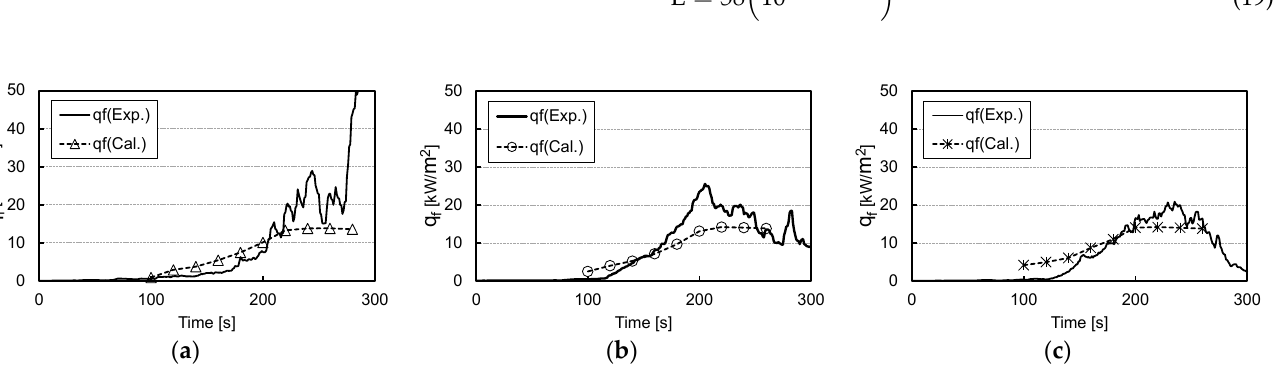
Figure 10. Comparison of calculated values by Shokri’s formula with experimental values: ( a ) HB=0 mm; ( b ) HB=215 mm; ( c ) HB=515 mm.